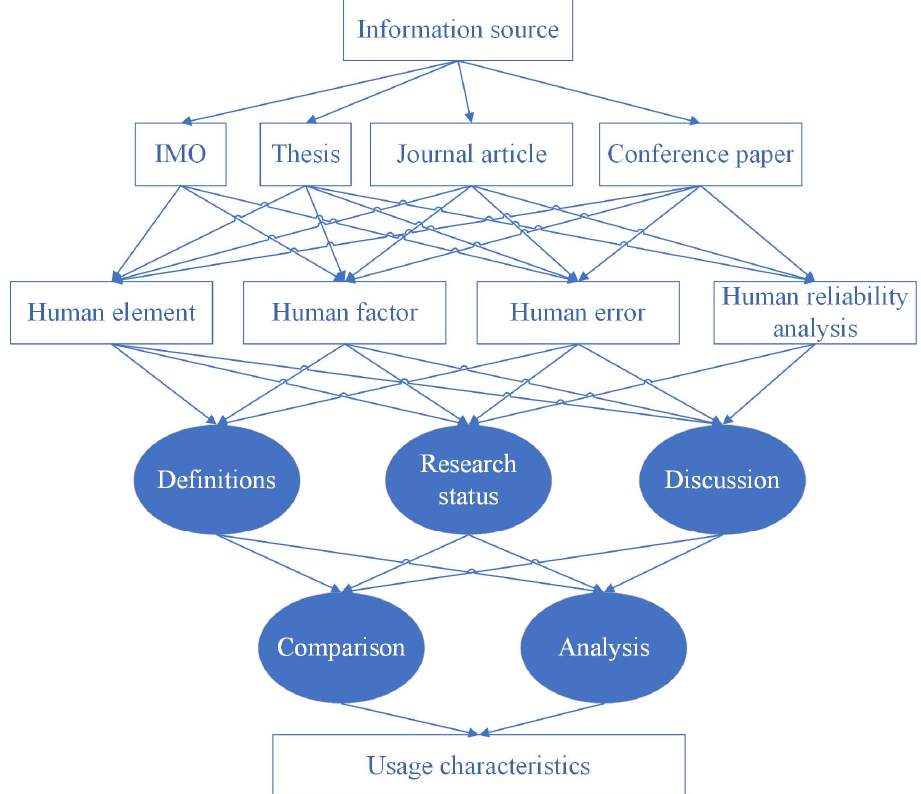
Figure 2. Flowchart of the research procedure.